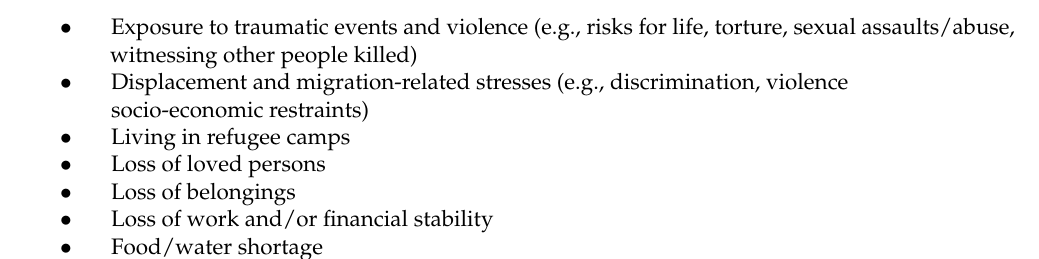
Table 6. War-related factors impacting mental